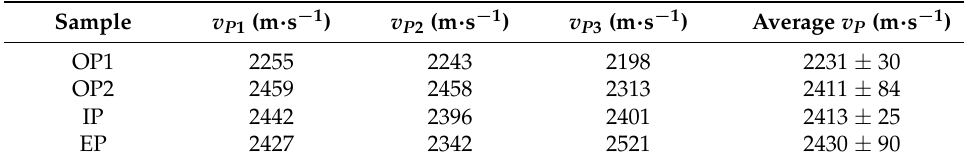
Table 2. Summary of longitudinal wave velocities of the different pure samples.